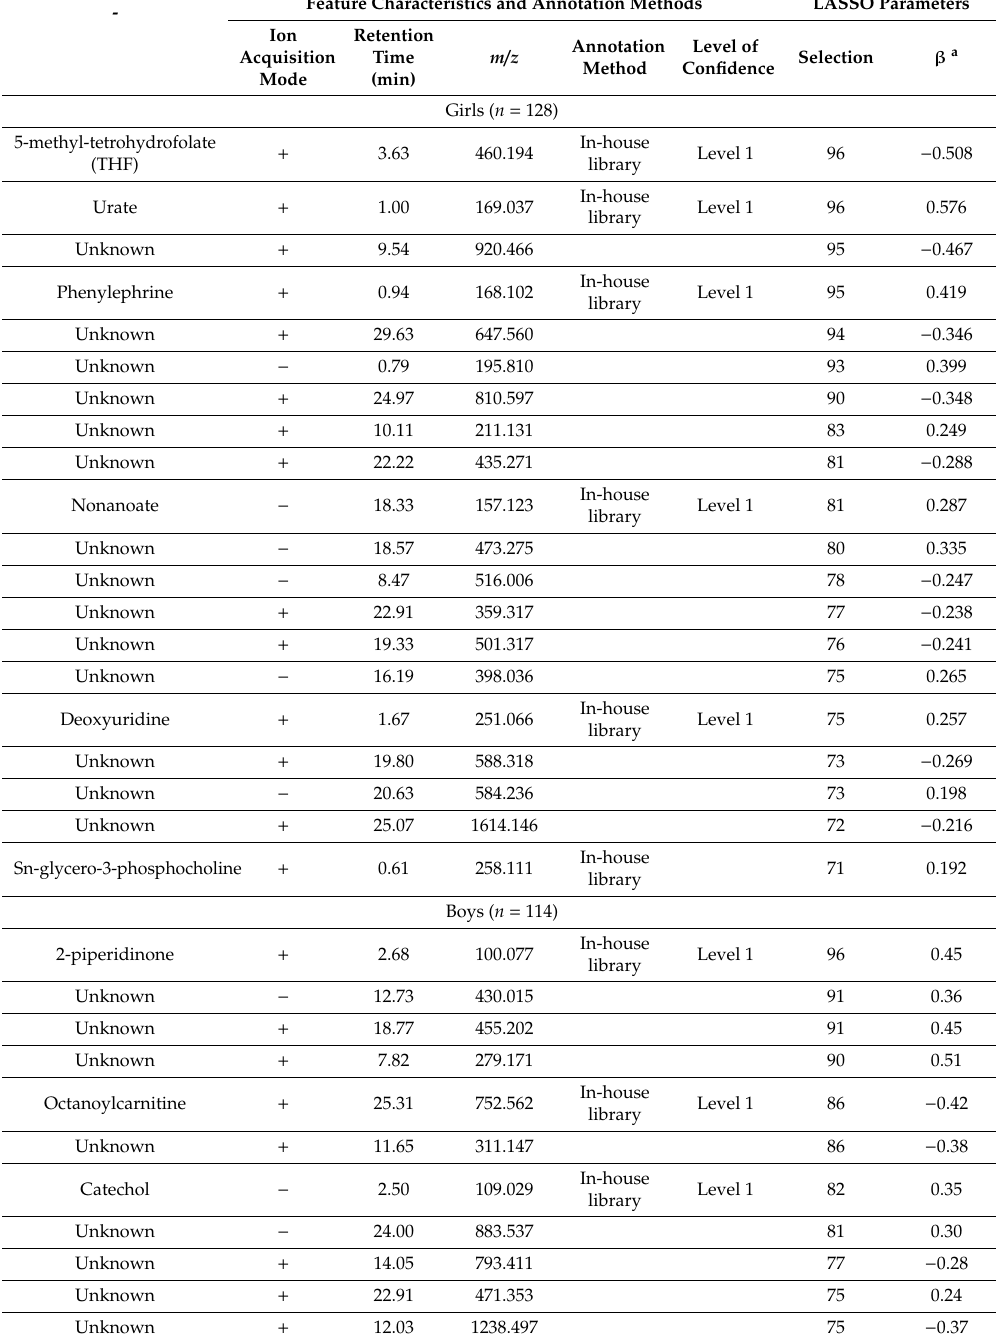
Table 3. Metabolites associated with quartiles of sugar-sweetened beverage (SSB) intake, selected via least absolute shrinkage and selection operator (LASSO)